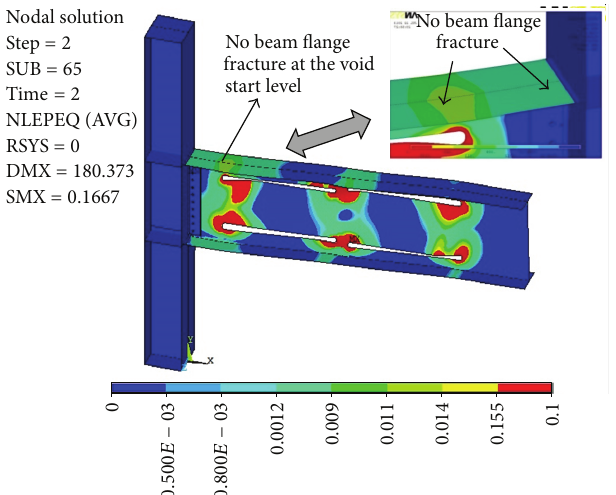
Figure 7: Plastic equivalent strain (PEEQ) distribution for modified specimen SAC7 with multivoids at five percent total rotation.